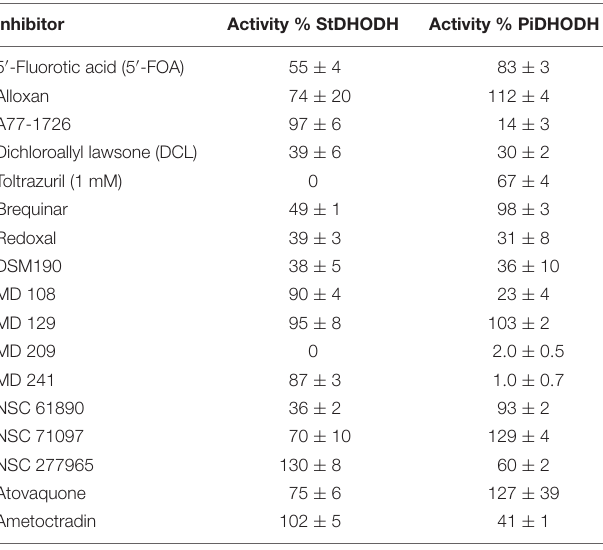
TABLE 3 | Activities of StDHODH and PiDHODH in the presence of potential inhibitors. Inhibitor